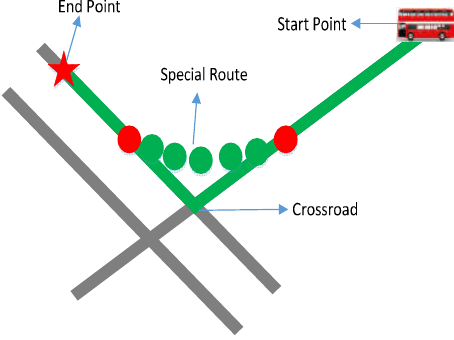
Figure 14. Search and get the special Curve Path.